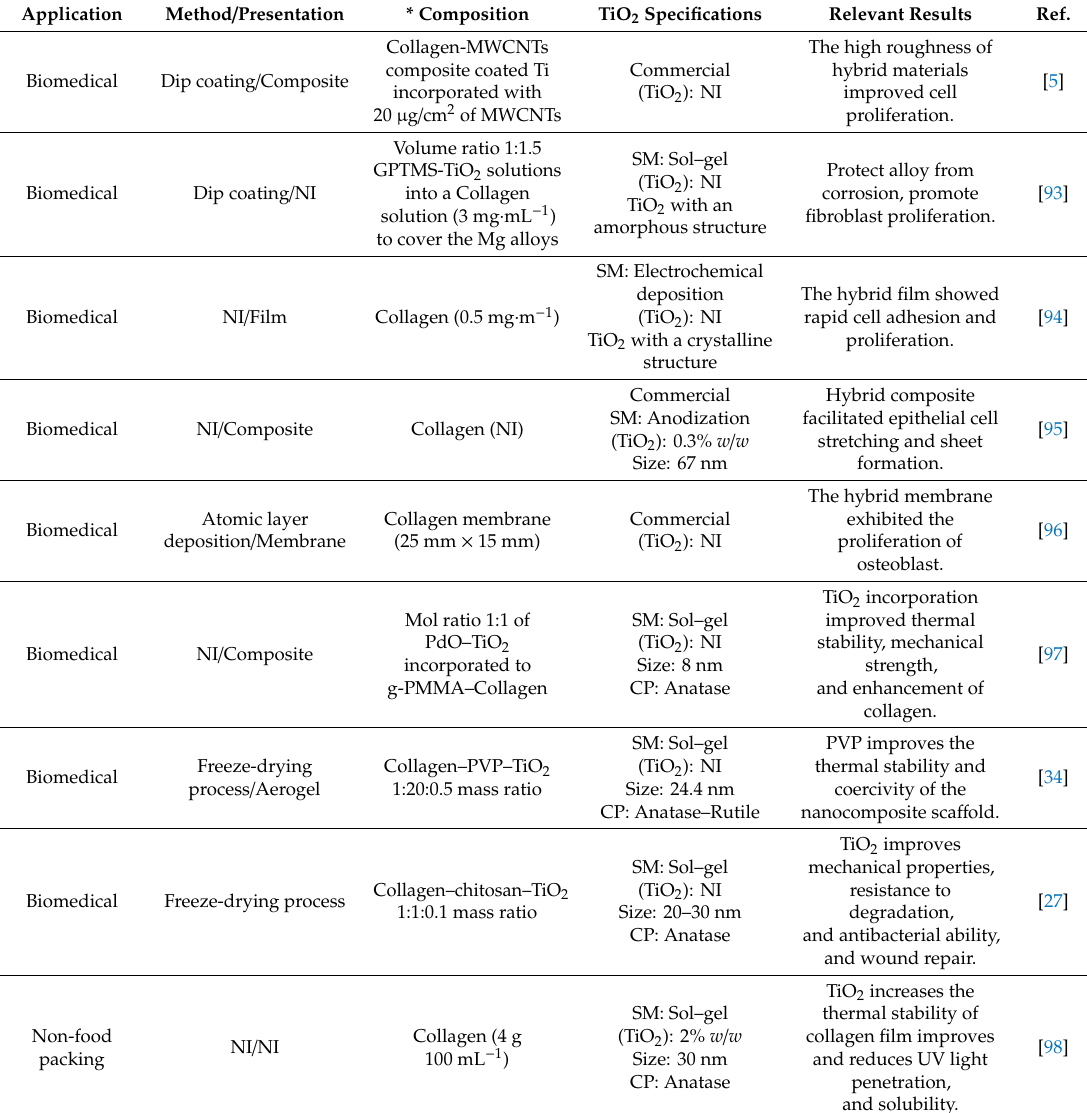
Table 6. E ff ect of TiO 2 incorporation on collagen-based